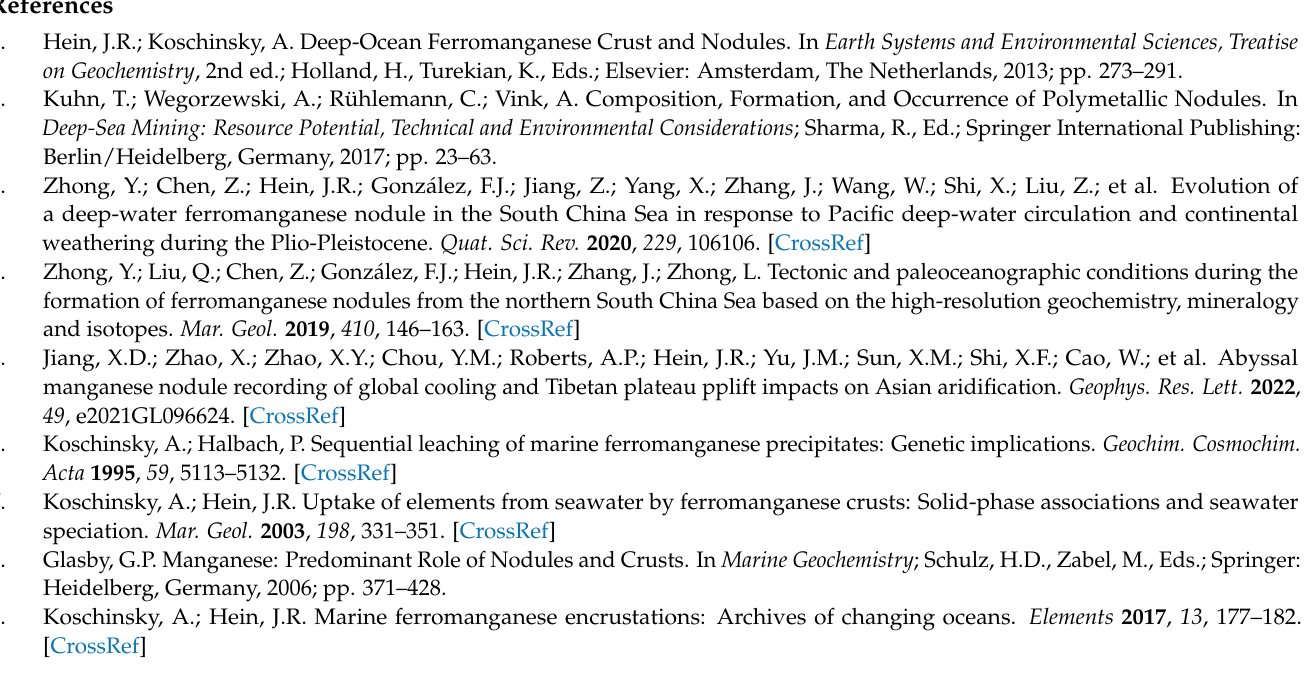
Figure S2: Microscopic investigations and depth profiles of element contents of D07; Tables S1: Locations and depths of the samples; Tables S2–S4: Chemical compositions obtained by EMPA; Table S5: Trace element compositions obtained by